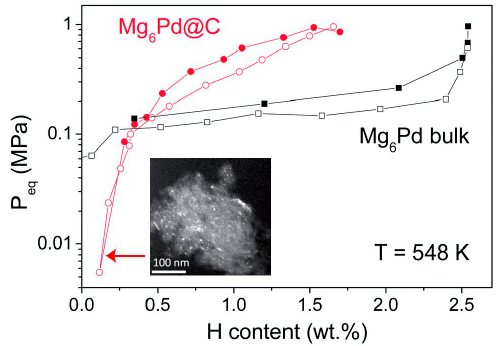
Figure 12. Hydrogen sorption isotherms at 548 K for bulk (black line) and nanoconfined (red line, TEM image in the inset) Mg 6 Pd. Filled and empty symbols stand for absorption and desorption isotherm curves, respectively. Reprinted with permission from Ref. [73]. Copyright 2014 The Royal Society of Chemistry.